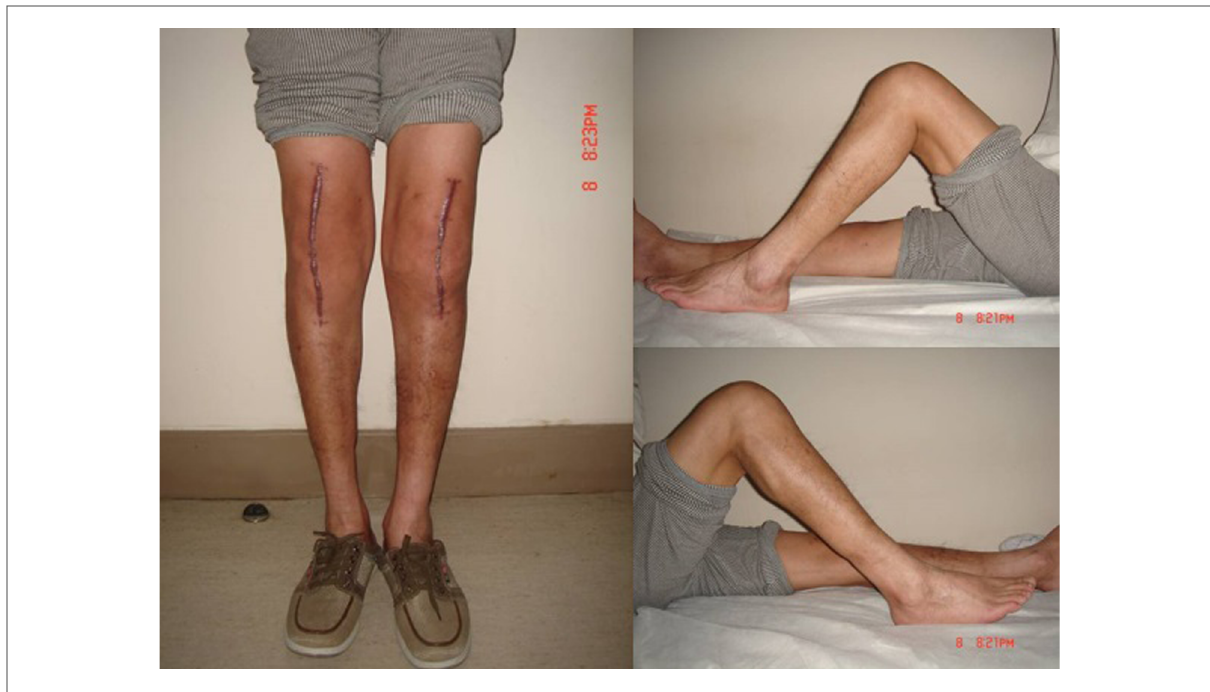
FIGURE 4 The deformity was completely corrected 6 weeks after